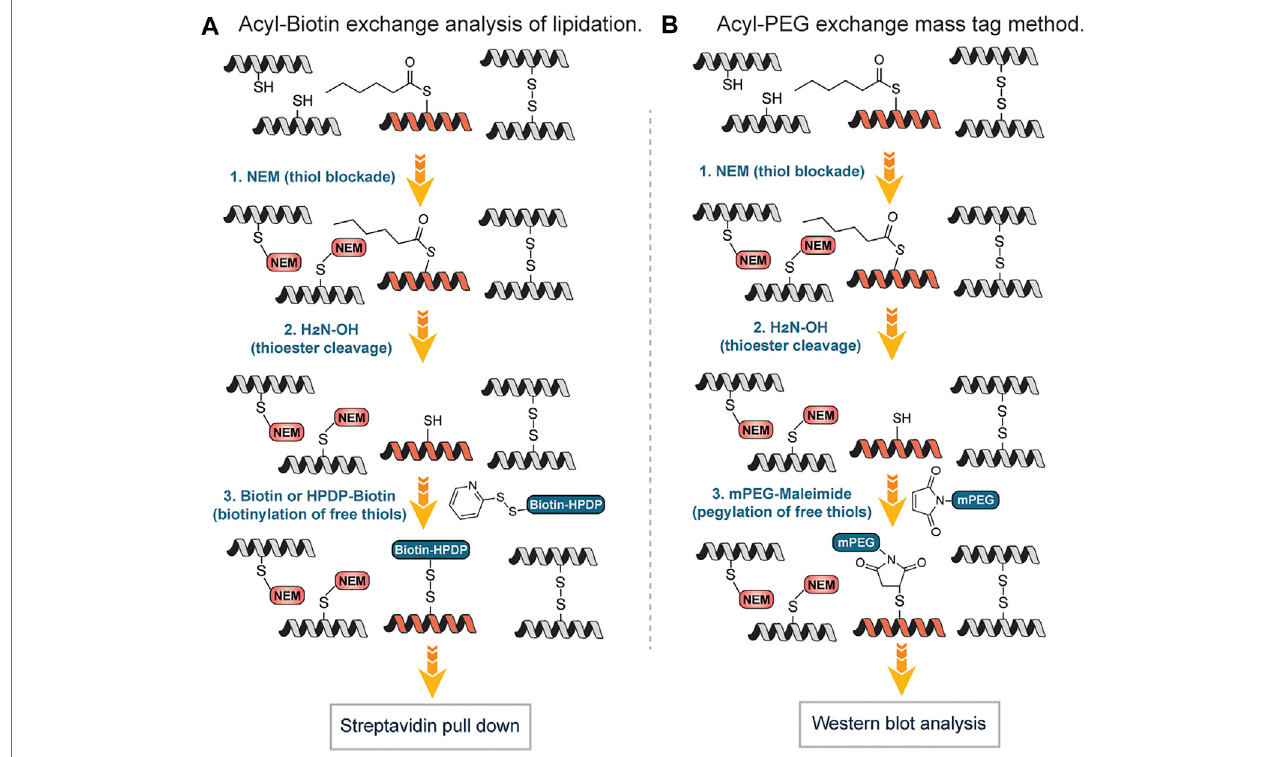
FIGURE 8 | (A) Work fl ow for S-lipidation detection and quanti fi cation using acyl-biotin exchange (ABE) mediated approach. (B) Mass-tag labeling approach of S-fatty acylation using acyl-PEG exchange (APE).